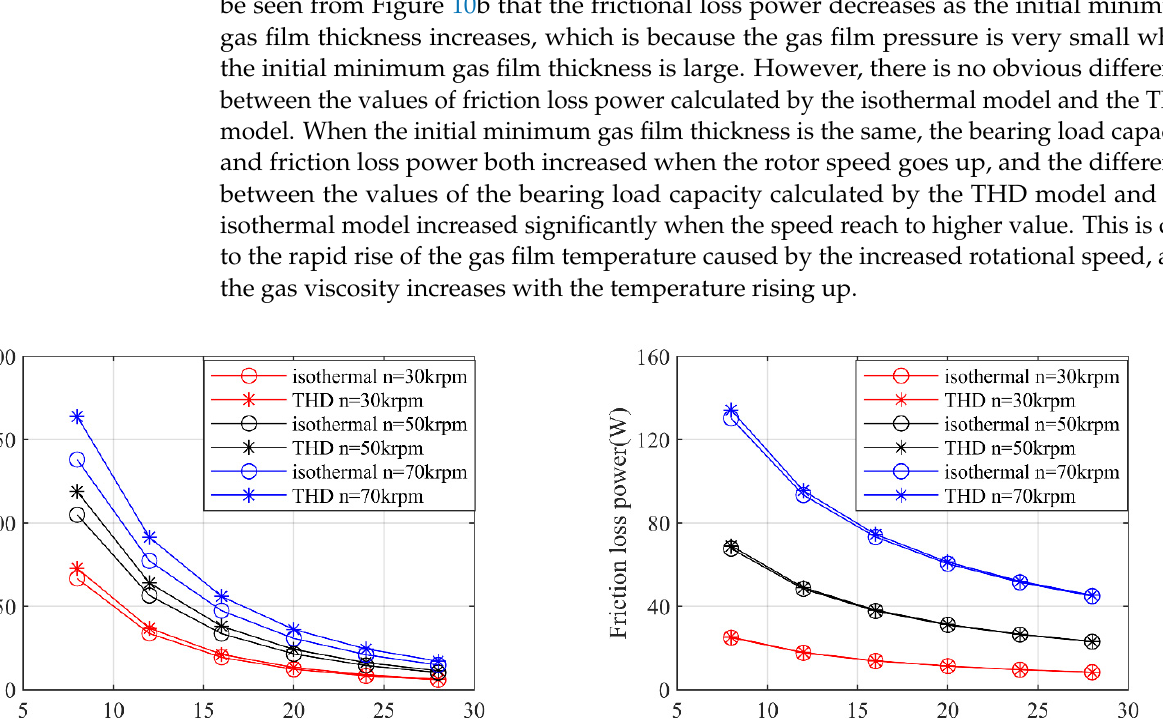
Figure 9. Dimensionless gas film pressure distribution under different thermal model. ( a ) Isothermal model; ( b ) THD model.